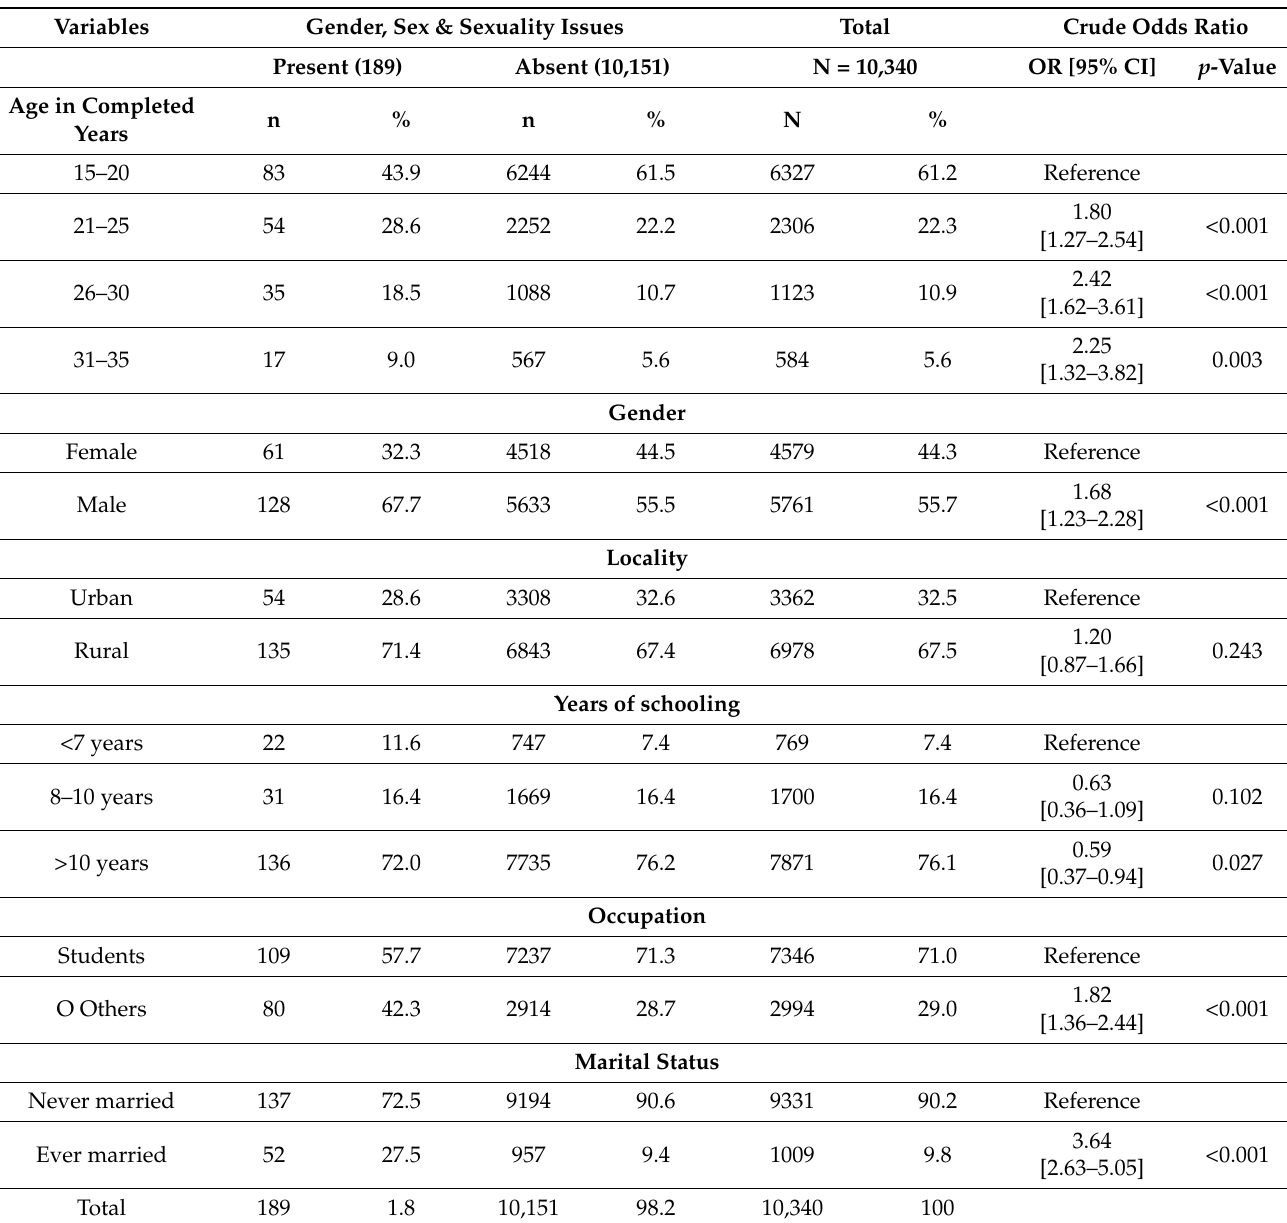
Table 1. Socio-demographic characteristics and gender, sex and sexuality issues among beneficiaries attending youth mental health promotion clinics in Karnataka. (2017–2020) (N =